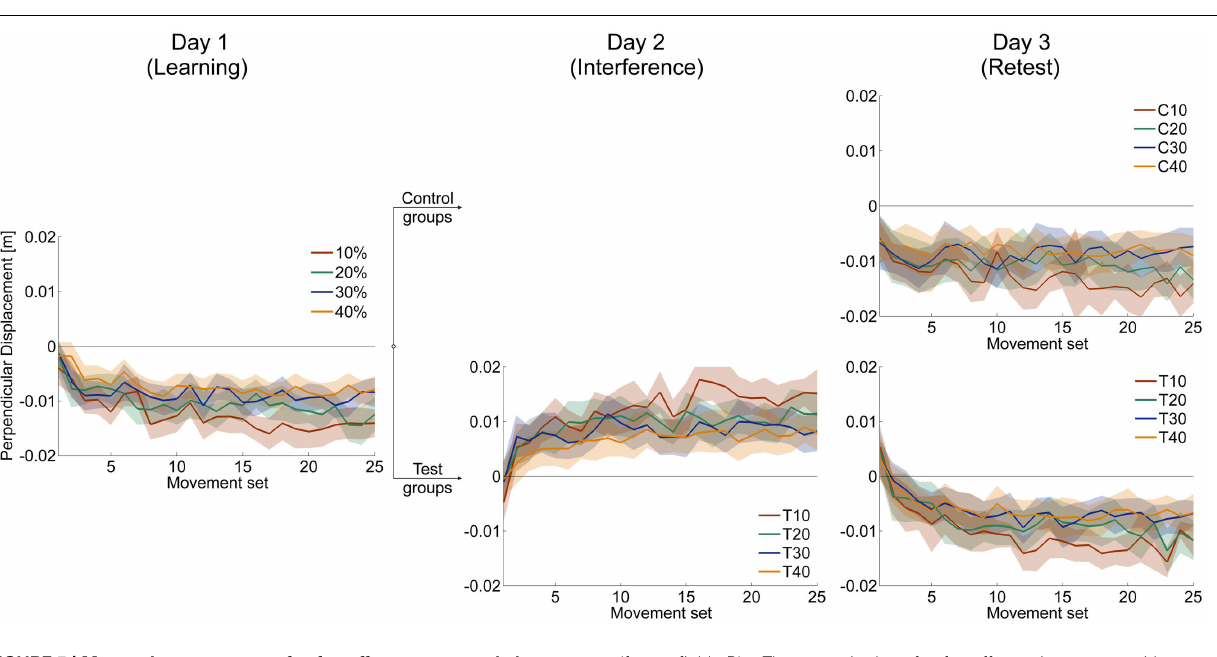
(force field B). The magnitude of after-effects increases with ongoing practice and is least for subjects receiving 30 and 40% catch trials. All data is presented as mean values ± 95% confidence intervals.